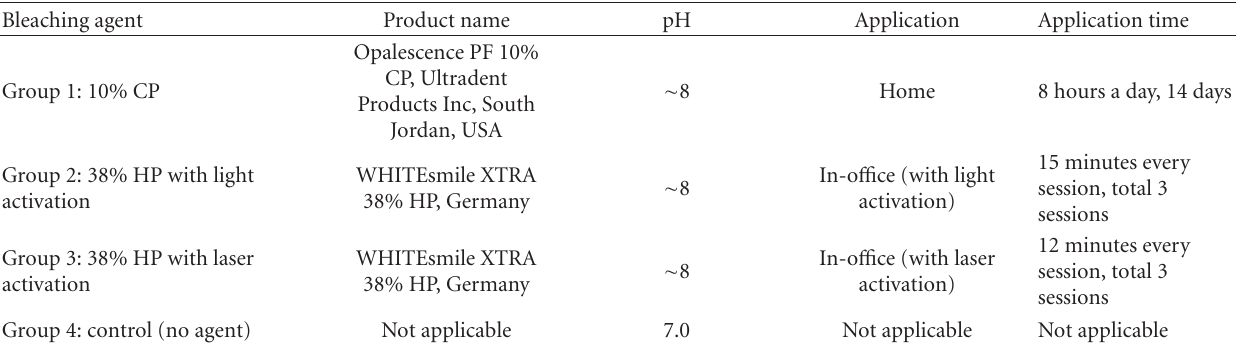
Table 1: Test groups ( n = 10 each